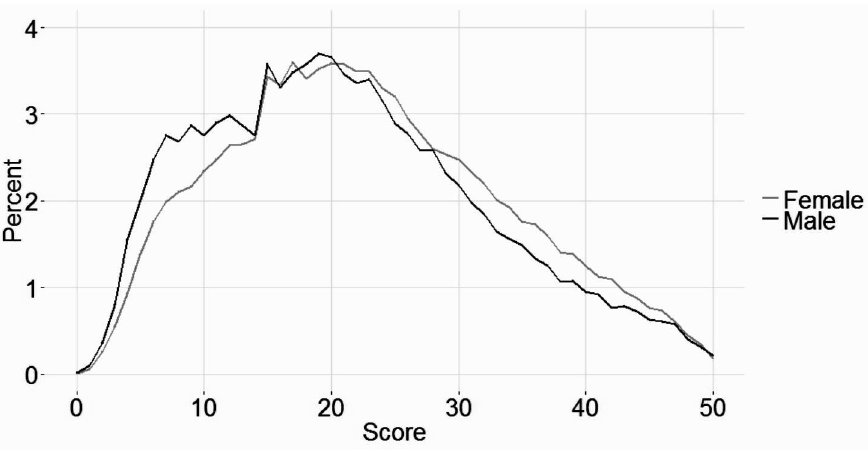
Figure 2. Percent of female and male on basic Matura after excluding population taking extended